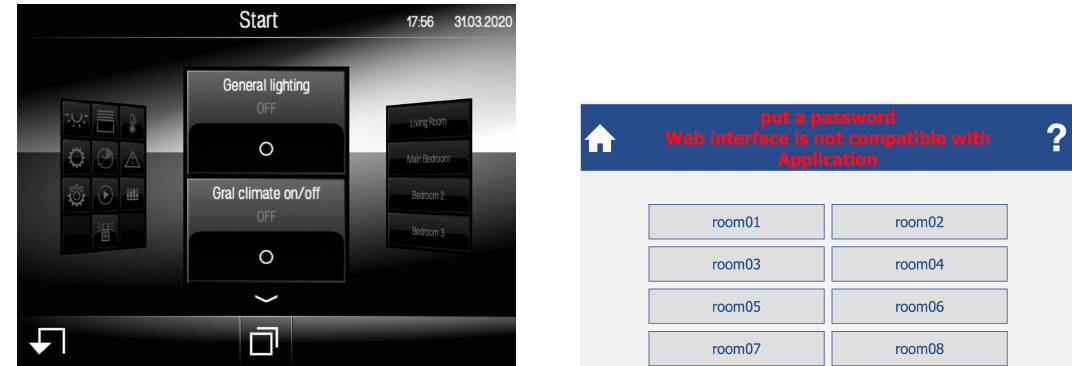
Figure 10. Screenshots of open Jung KNX ( left ) and Insteon ( right ) home automation